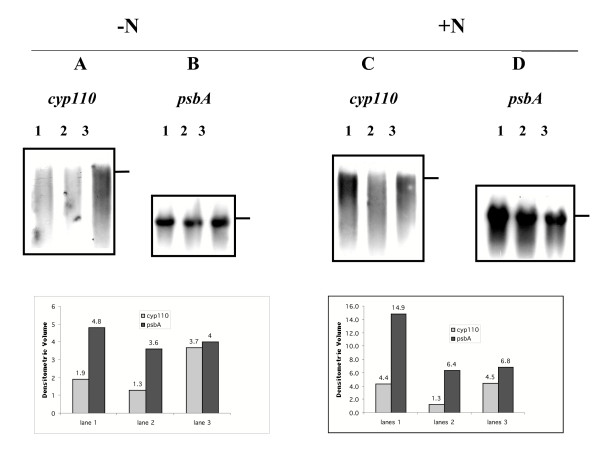
Expression of cyp110 and psbA transcripts in nitrogen-fixing and ammonia-supplemented Anabaena 7120 cultures. Anabaena 7120 control and test cultures were grown in nitrogen-free (-N) and ammonia-supplemented (+N) Chu #10 media. Test cultures were treated with 0.2 % (v/v) dodecane or hexadecane for 2 hours. Fifteen microgram samples of total Anabaena 7120 RNA from each treatment were size fractionated, transferred to a nylon membrane and probed with a cyp110 probe (panels A and C). RNA blots were stripped and reprobed with a psbA probe (panels B and D). Lanes (1) untreated control, lanes (2) dodecane treatment, lanes (3) hexadecane treatment. Bars on left side of each panel denote the approximate transcript sizes (A, and C = 8.5 kb, B and D = 1.3 kb). Quantification data is shown below each northern blot.